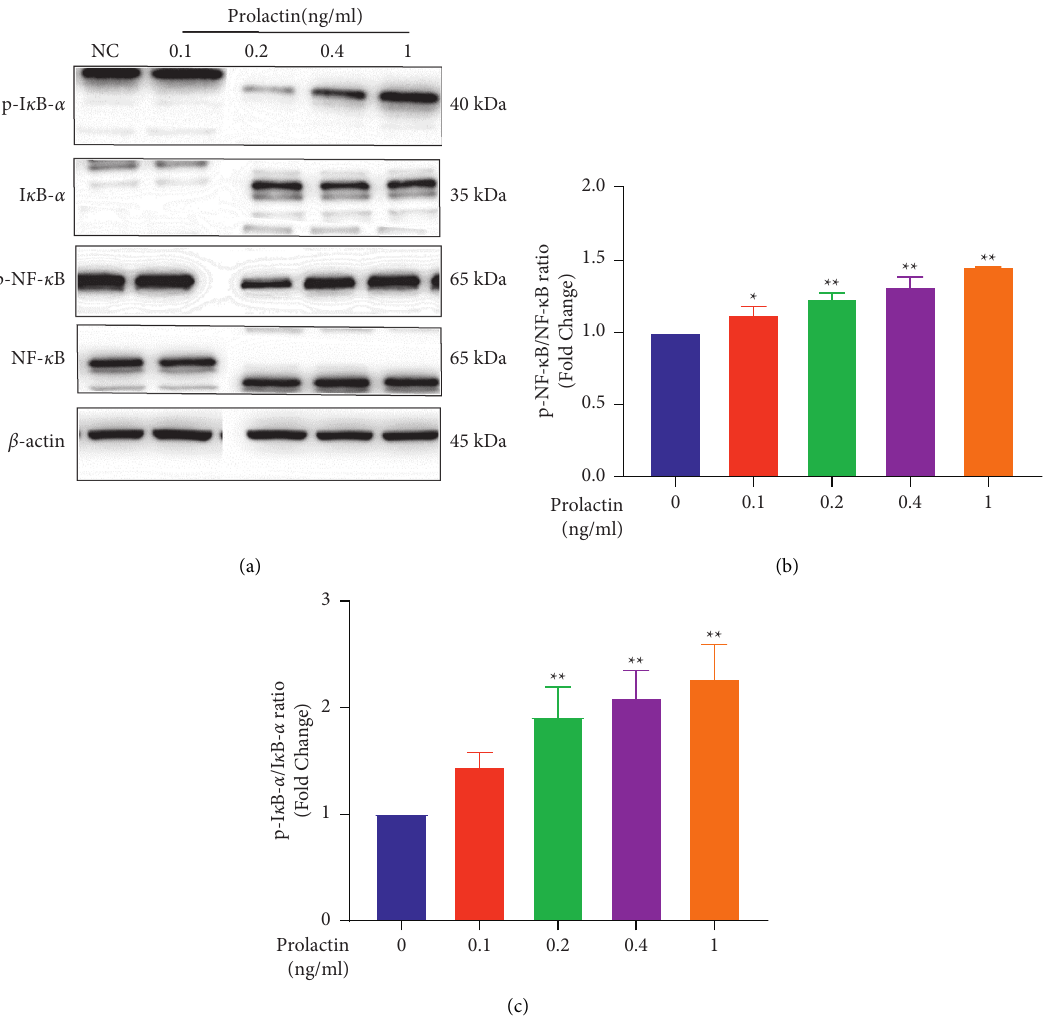
Figure 5: Prolactin activated the NF- κ B signaling pathway during osteoblastogenesis. (a) Cell lysates were subjected to WB analysis with antibodies against phospho-I κ B- α , I κ B- α , phospho-NF- κ B, and NF- κ B. (b and c) The ratios of p-I κ B- α /I κ B- α and p-NF- κ B/NF- κ B. n � 3, NS: not statistically significant, ∗ P < 0 . 05, ∗∗ P < 0 . 01, ∗ vs the NC